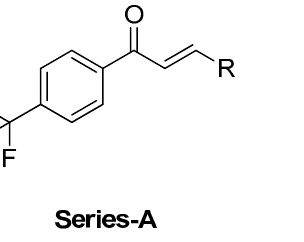
Figure 3. General structures of the designed target fluorinated chalcones.